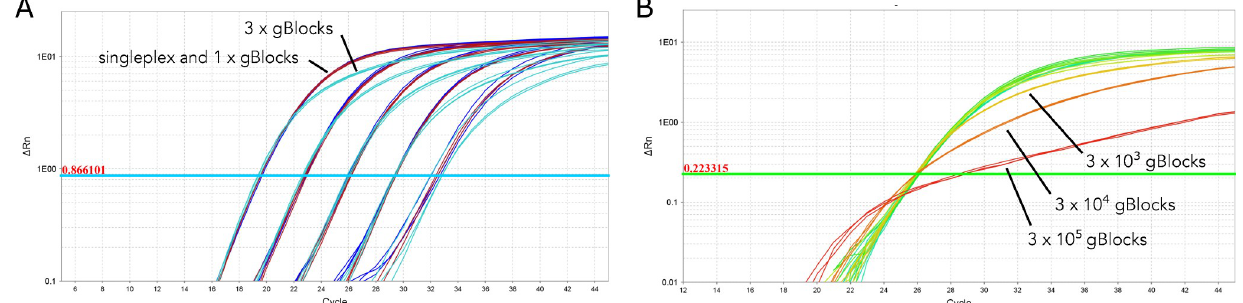
Fig 5. Amplification plot in logarithmic view. A. Comparison of the amplification of the Pacific hake gBlocks standards in a multiplex with the other two species combined and individually. B. Comparison of the amplification of the IPC for the non-template controls and the gBlocks standards combined at different concentrations (in copies μ l -1 ) and some eDNA